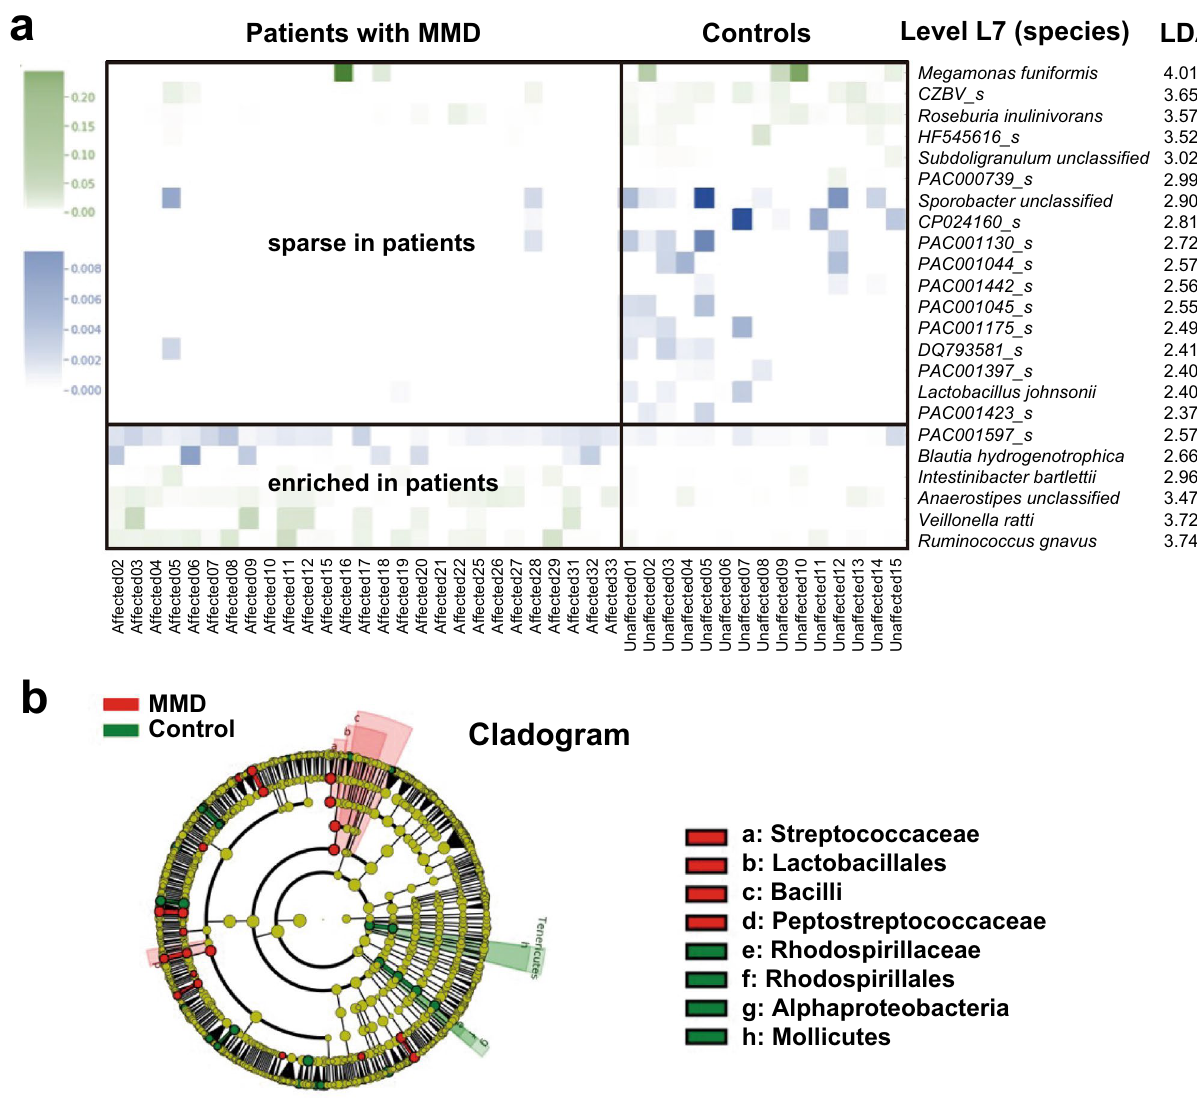
Figure 2. Relative abundance analysis of gut microbiota. ( a ) The LEfSe analysis showed several microbial taxa that were significantly different between patients with MMD and control individuals. The discriminative taxa with top ranked LDA scores at the species level (L7) are shown. Heatmap demonstrates distinct patterns between patients with MMD and controls. Blue represents microbes with lower relative abundance (mostly < 0.001 as shown in the scale bar in the left panel), and green represents microbes with relative abundance higher than the blue ones. ( b ) The cladogram of the discriminative taxa identified by LEfSe was shown. Streptococcus of the Firmicutes Bacilli class, and Lactobacillales were enriched in patients with MMD as compared with controls, whereas Alphaproteobacteria of the Proteobacteria division, Rhodospirillaceae, and Mollicutes were enriched in